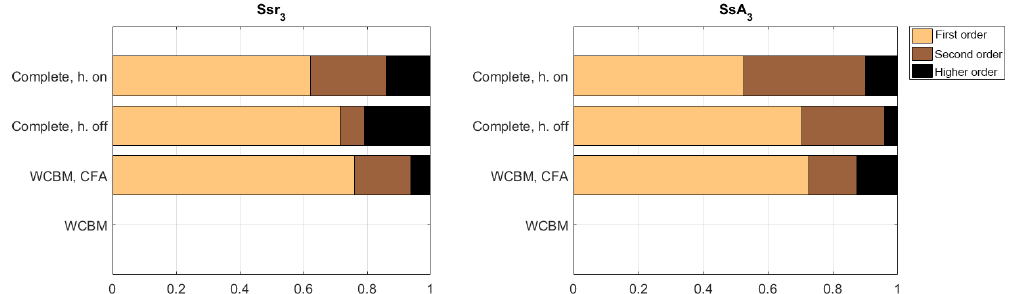
Figure 10. Sensitivity of the stability indices taking into account the three modes to first, second, and higher orders of interaction. Models of increasing complexity from bottom to top.